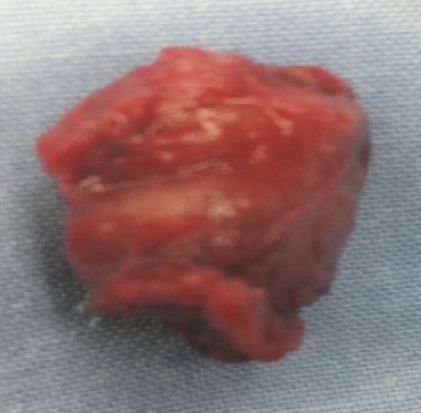
Figure 3: Paraganglioma of carotid tumor after surgical resection.